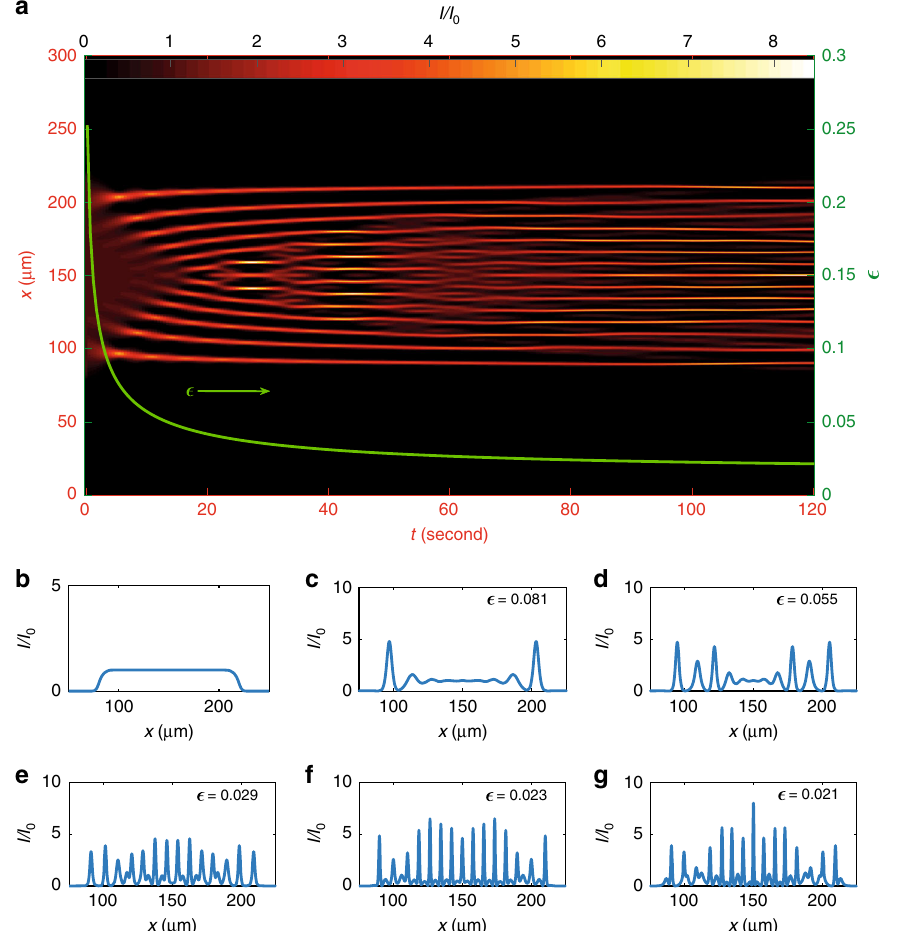
Fig. 2 Controlling the extreme wave genus. a Numerical simulation of the control of the fi nal state after a propagation distance L ¼ 2 : 5 mm for an